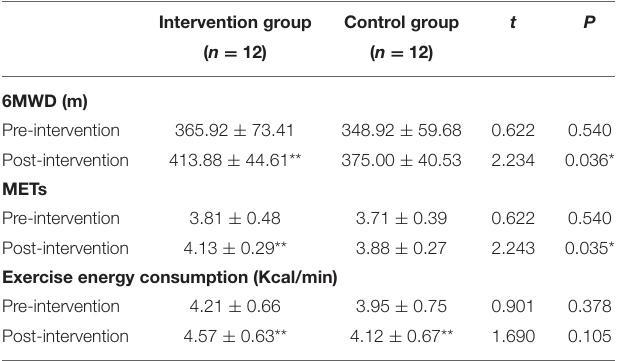
TABLE 2 | 6MWT measures between the two groups (x ± s).